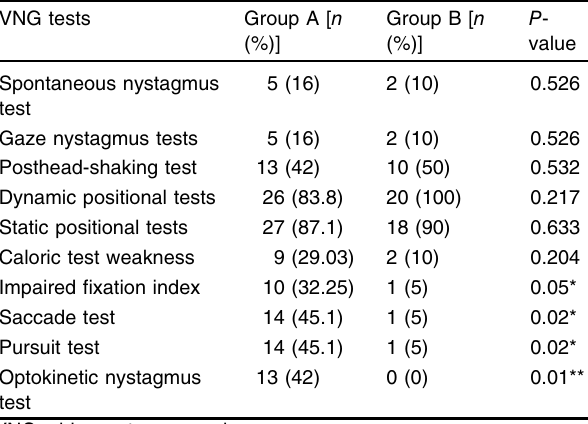
Table 2 Videonystagmography findings in group A versus group